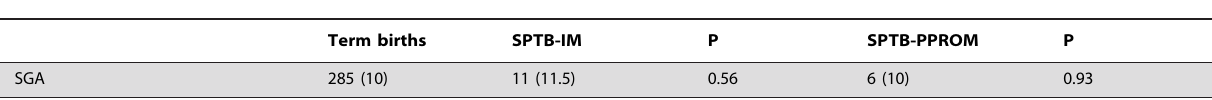
Term births SPTB-IM